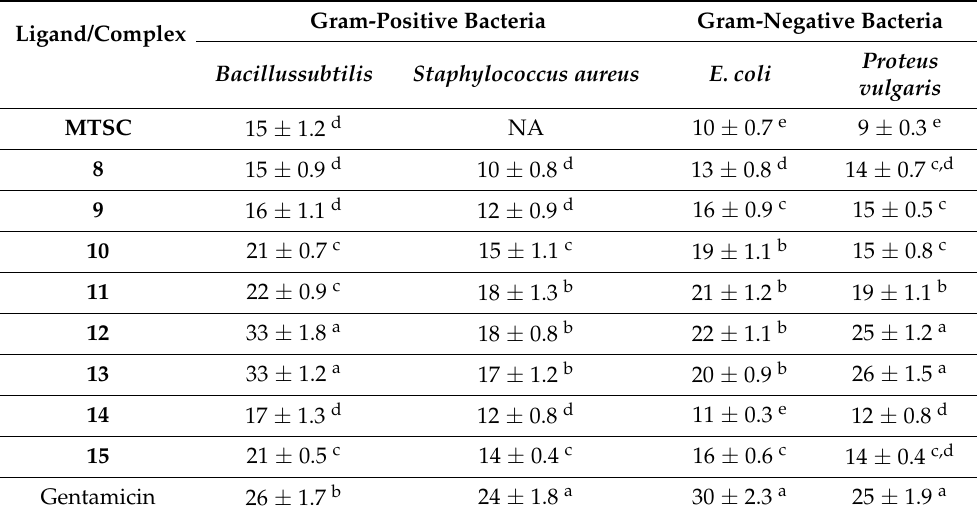
Table 5. Antibacterial assessment (inhibition zone diameter) of MTSC ligand and its metal complexes at a concentration of 1 µ